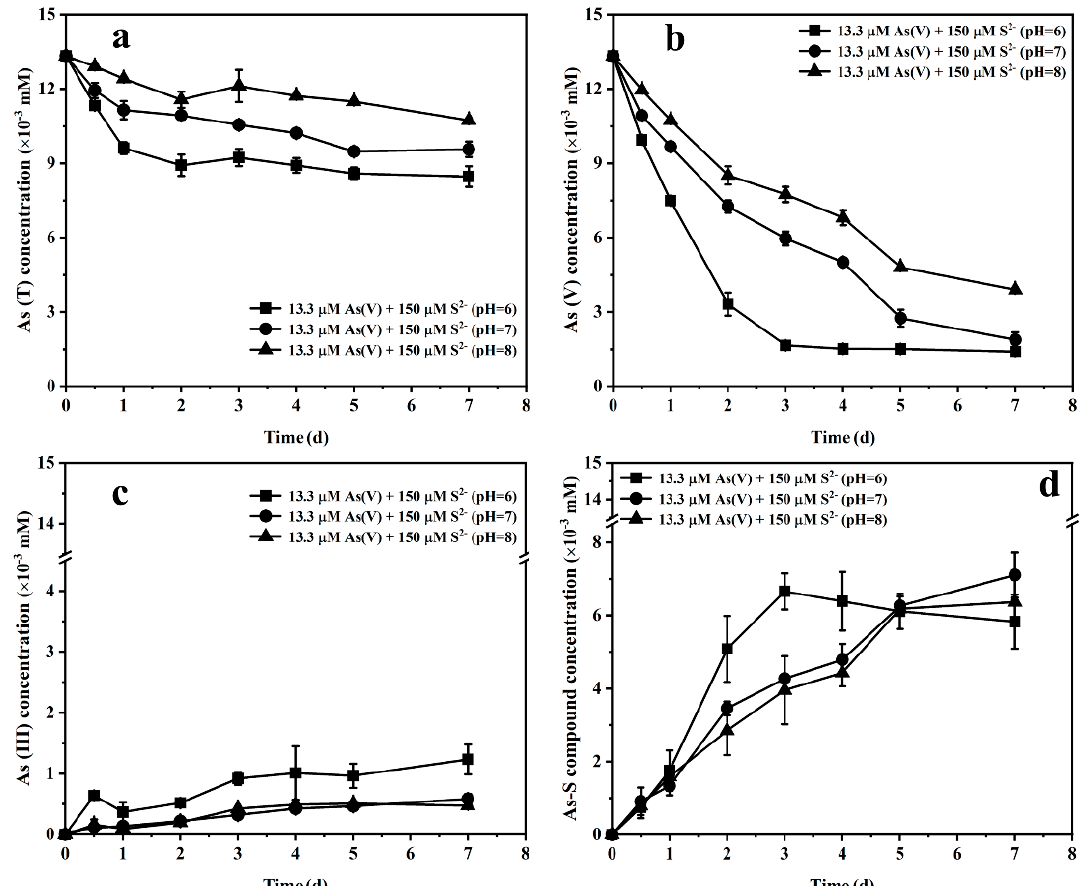
Figure 5. The concentrations of As(T) ( a ), As(V) ( b ), As(III) ( c ) and As–S ( d ) in the medium with strain JH012-1 at pH 6, 7 and 8.